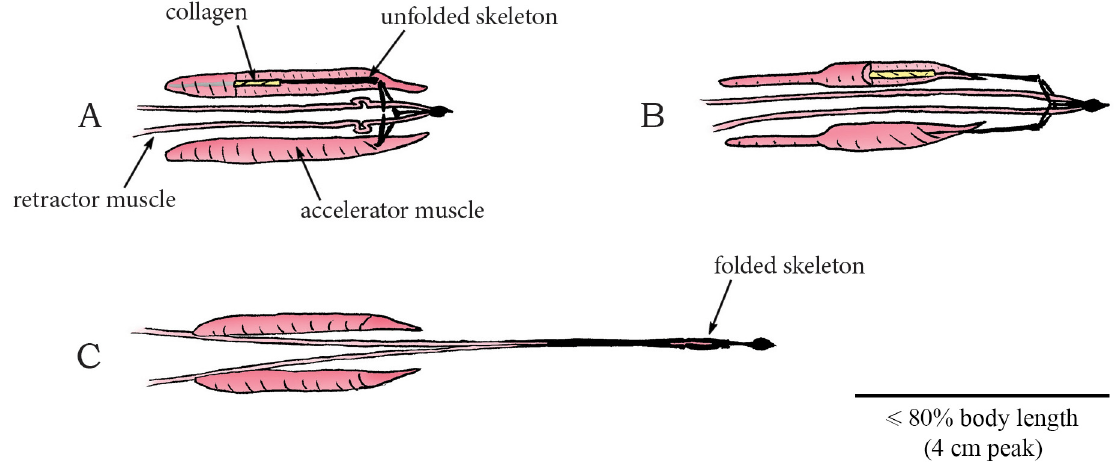
Fig 24. The muscle-powered squeeze catapult mechanism in the family Plethodontidae or lungless salamanders (species Hydromantes supramontis ). (A) The tongue with the unfolded tongue skeleton, two accelerator (or protractor) muscles, collagen fibers in the sheaths between the accelerator muscles, and retractor muscle. (B) Contraction of the accelerator muscle loads the sheaths with elastic energy and forces the two posterior ends of the skeleton forward. (C) Folding of the tongue skeleton to the midline during discharge. Drawings based on schematic drawings in [127]. Scale bar indicates a length of up to 80% of the body length (peak launch distance 4 cm in Hydromantes genei